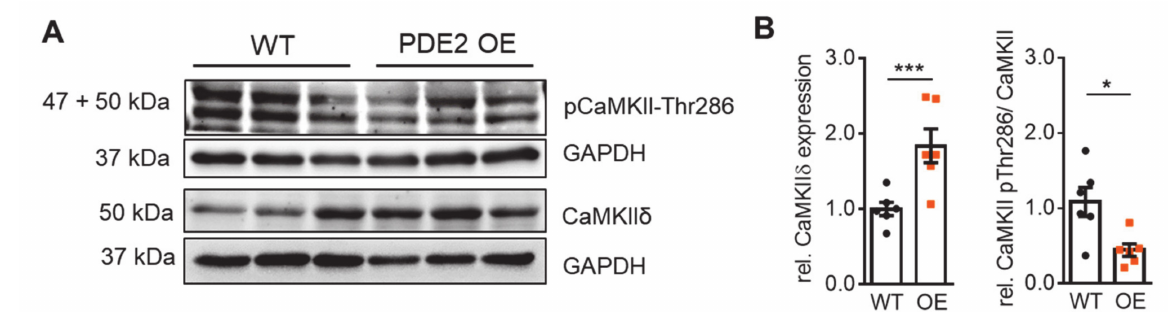
Figure 5. Basal expression and phosphorylation of CaMKII is affected by PDE2 overexpression. ( A ) Representative immunoblots and ( B ) quantification of protein kinase expression normalized to GAPDH, CaMKII phosphorylation at Threonine 286 normalized to total CaMKII δ in lysates of isolated cardiomyocytes from PDE2 OE (orange) and WT (black) mice. (N = 6 animals/genotype. * p < 0.05, *** p < 0.001 vs.